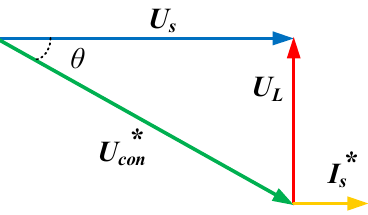
Figure 12. AC side phasor diagram of unidirectional rectifier.